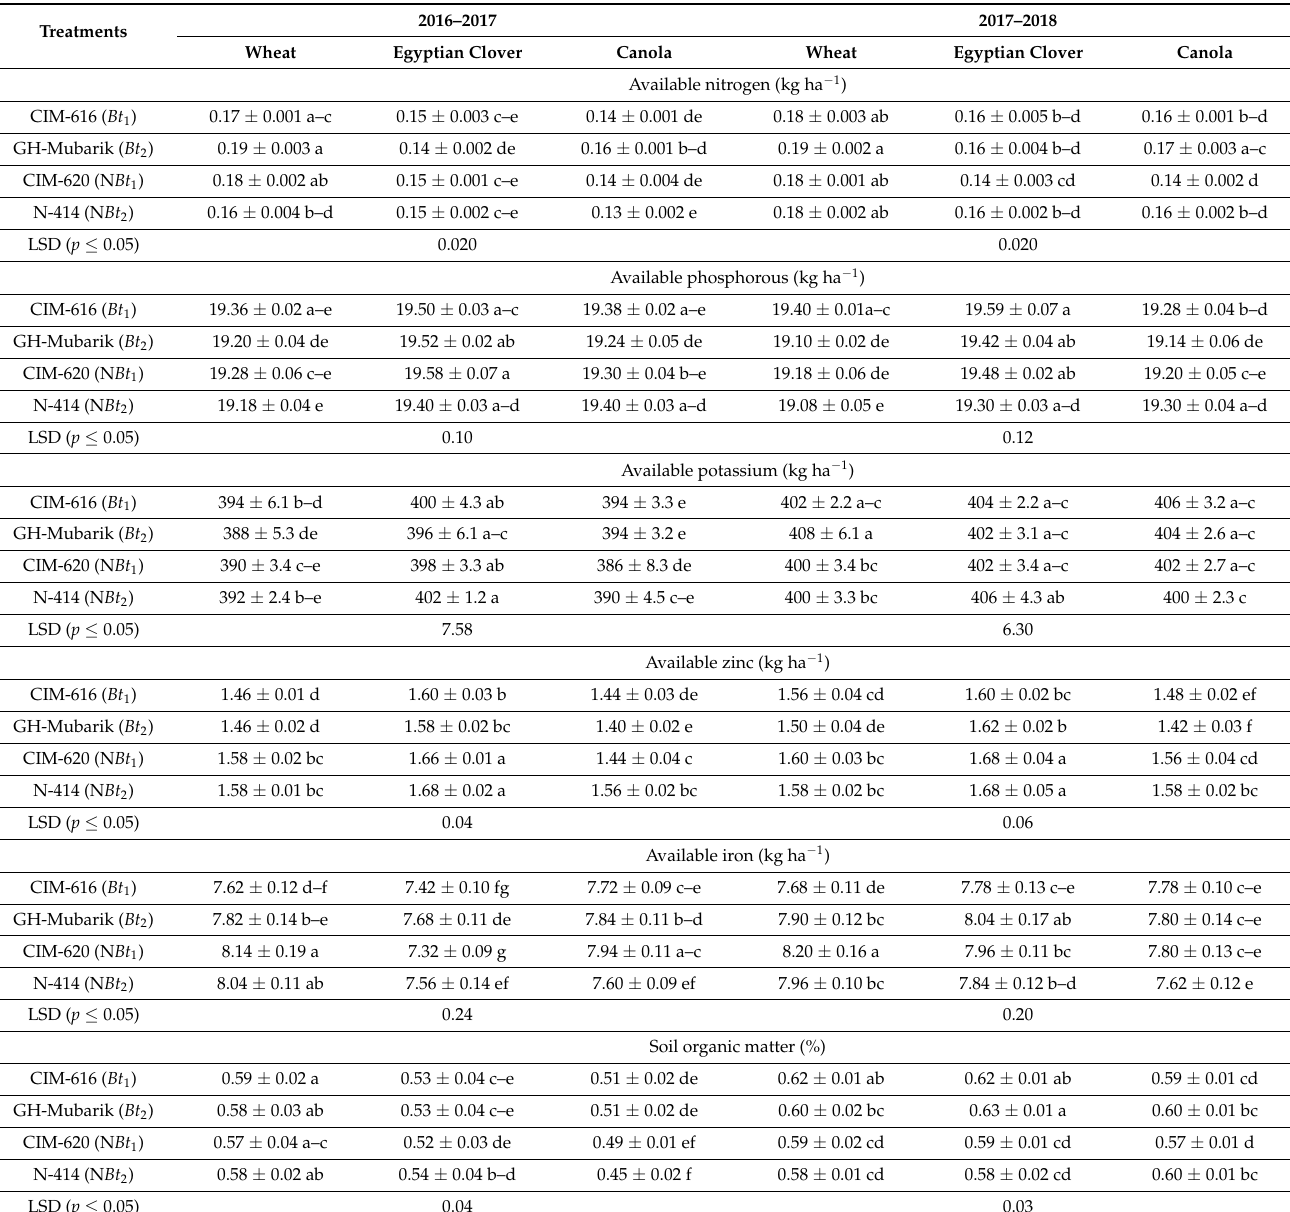
Table 3. The influences of cotton genotypes from winter crops interaction on nutrient availability and soil organic matter contents in the soil after the harvest of winter